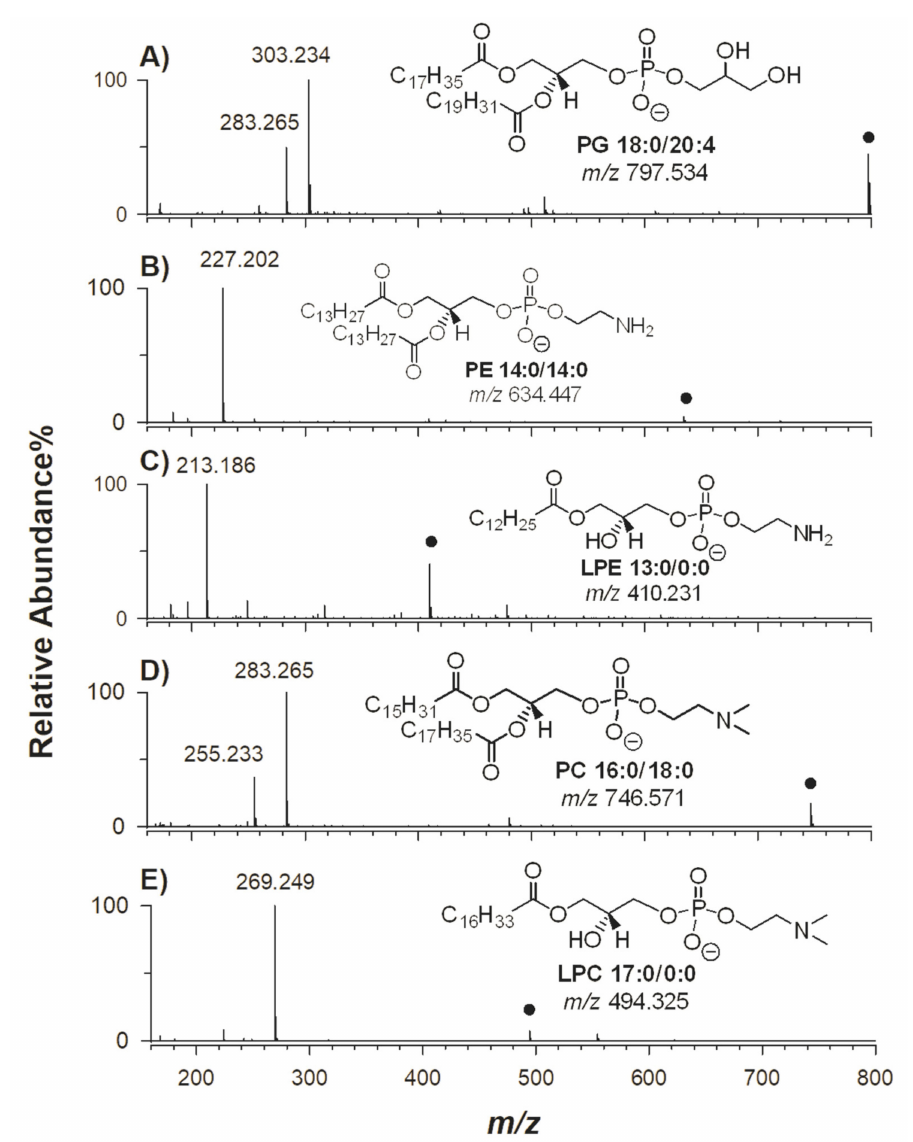
Figure 2. AIF MS spectra integrated under HILIC-ESI-FTMS peaks related to standard phospholipids referred to in Figure 1: ( A ) PG 18:0 / 20:4, ( B ) PE 14:0 / 14:0), ( C ) LPE 13:0 / 0:0, ( D ) PC 16:0 / 18:0 and ( E ) LPC 17:0 / 0:0. In all graphs, fatty acids (FA)-related signals represent the base peaks. Molecular structures of standard phospholipids (PL) are also